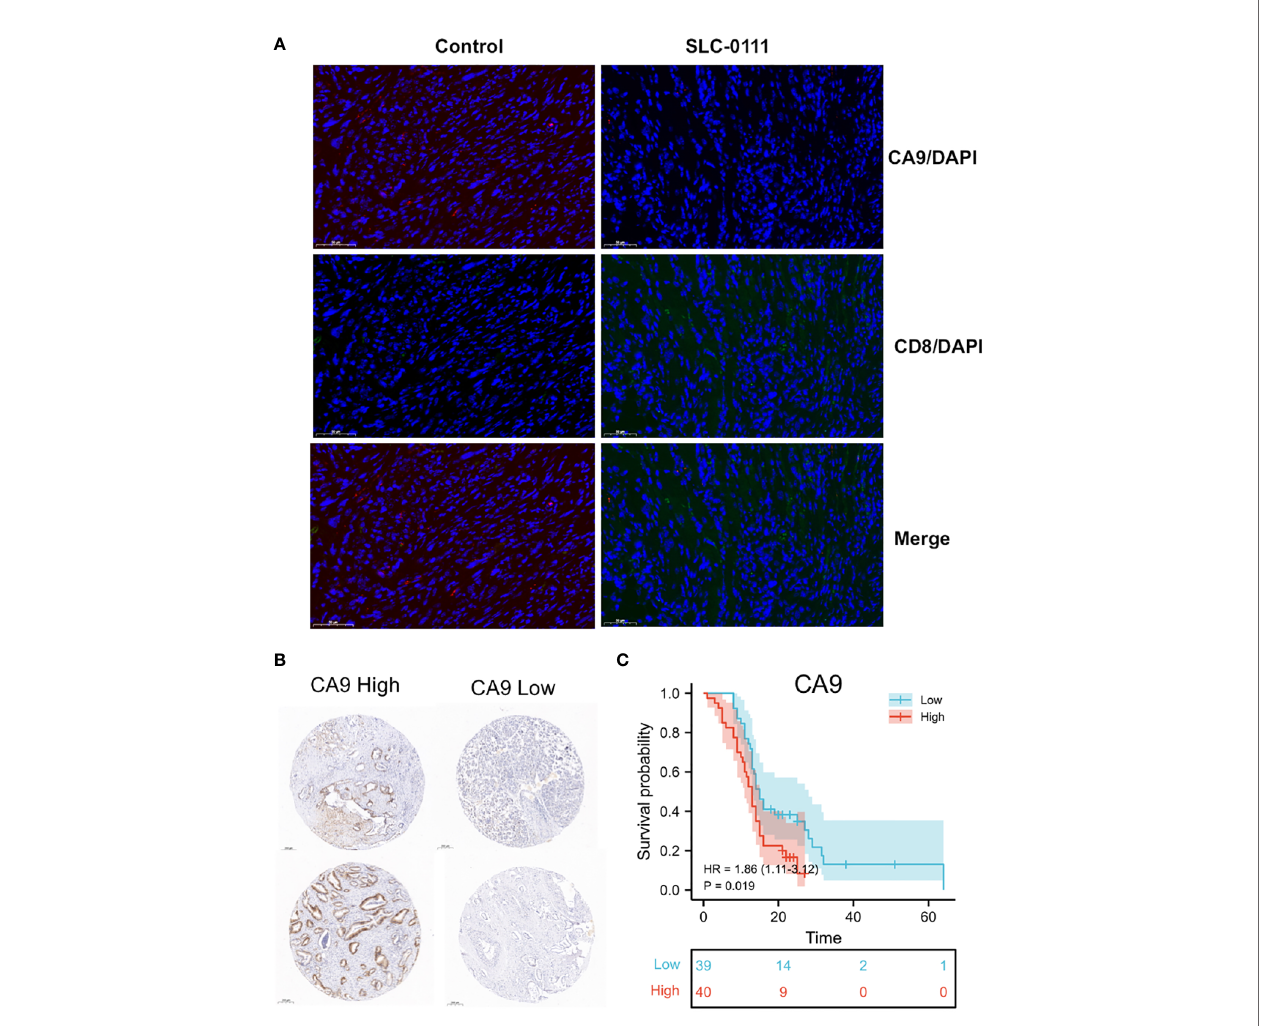
FIGURE 6 | (A) SLC-0111 inhibits CA9 expression and up-regulate CD8+ T cells in vivo . (B) TMA IHC analysis showed that CA9 high expression is associated with worse survival (Examples of CA9 expression in pancreatic cancer patients). (C) CA9 expression is signi fi cantly associated with overall survival of